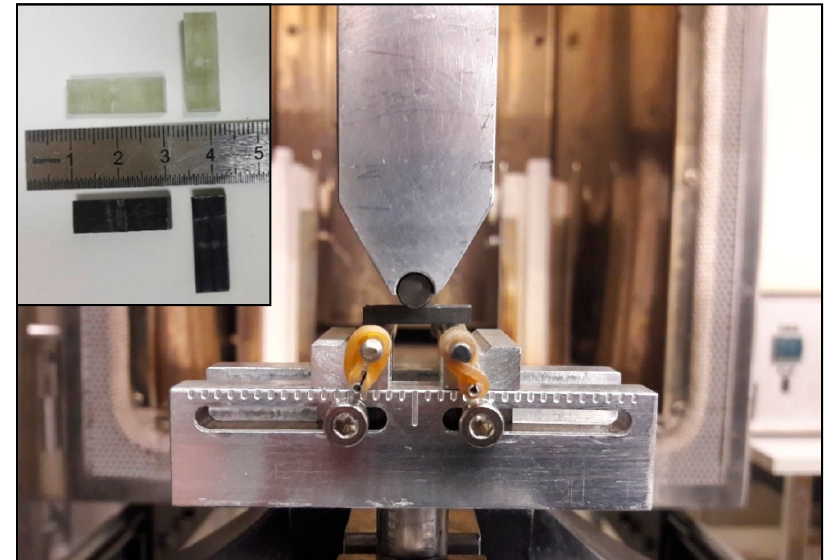
Figure 6. Short-beam tests and specimens.